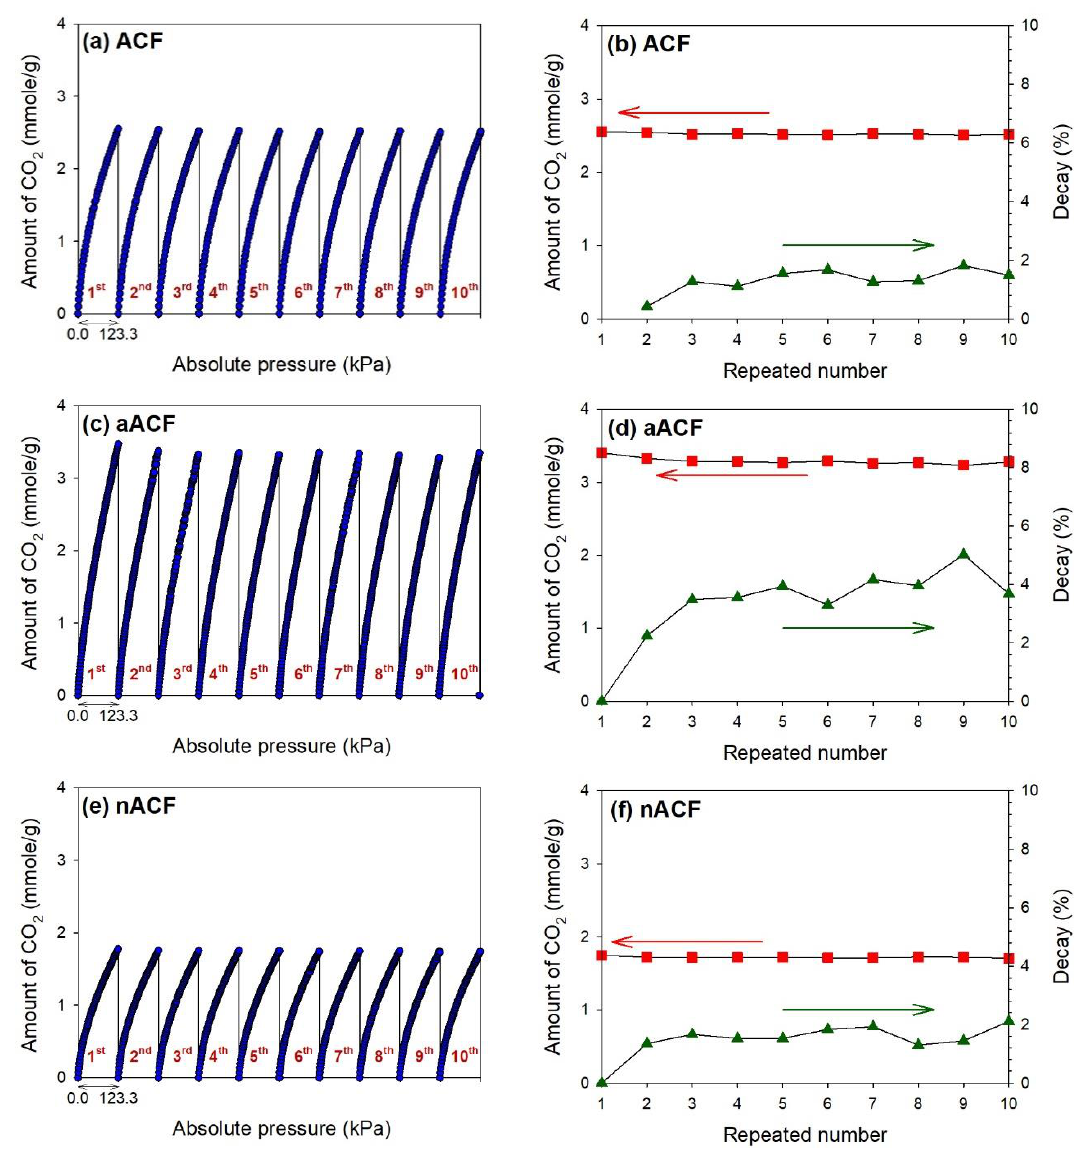
Figure 8. Successive cyclic adsorption/desorption curves and the variation of adsorption capacities at 25 ◦ C: ( a, b ) as-received ACF; ( c, d ) KOH-activated ACF (aACF); ( e, f ) TEPA-modified ACF (nACF).